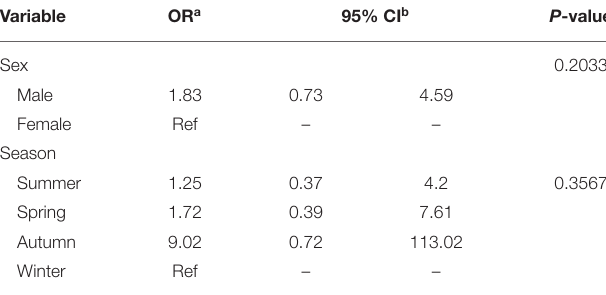
a Odds Ratio. b Confidence